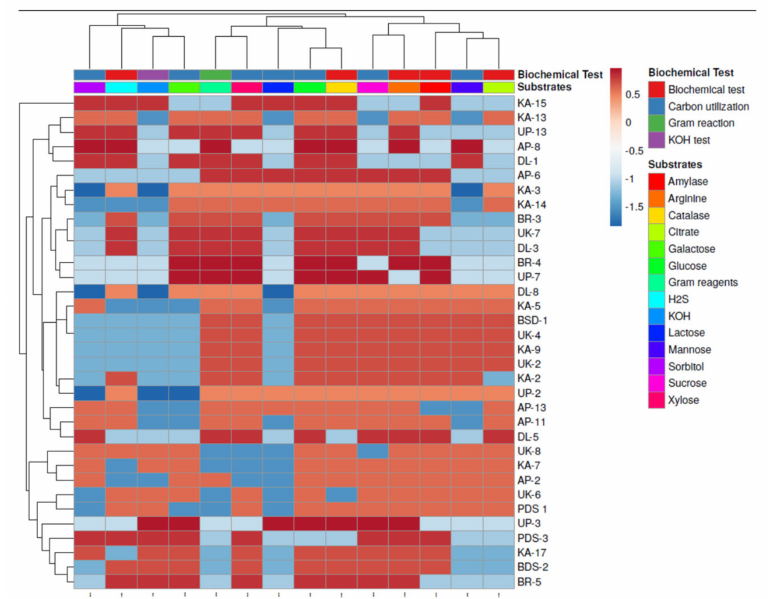
Figure 3. Clustering analysis and heatmap based on biochemical characterization of rhizobacterial strains isolated from different regions. The results are expressed as average of three